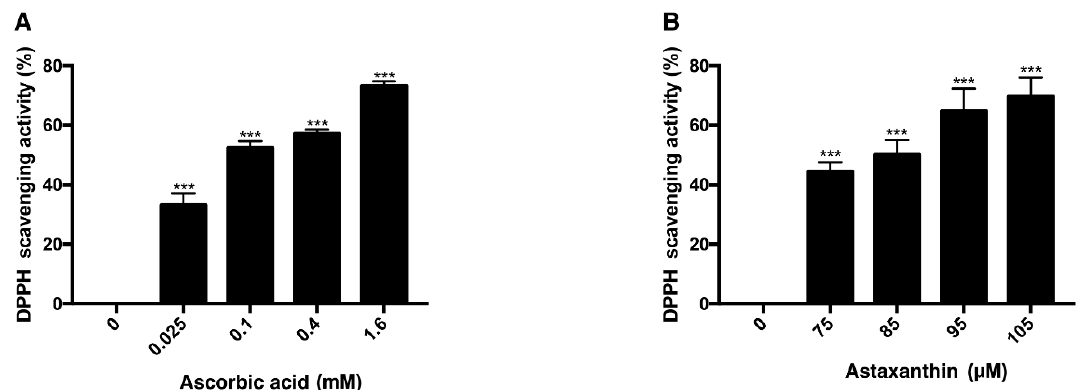
Figure 3. DPPH scavenging activity of ascorbic acid and astaxanthin. The antioxidative capacities of ascorbic acid and astaxanthin were determined by their capabilities to scavenge DPPH. Ascorbic acid (0.025–1.6 mM) was reacted with DPPH ( A ), and astaxanthin (75–105 µ M) was reacted with DPPH ( B ). The compounds were diluted in DMSO. Both compounds scavenged DPPH in dose-dependent way in 30 min of reaction time. Asterisks indicate a significant increment in DPPH scavenging activity compared with controls (*** p < 0.001). DPPH, 2,2-diphenyl-1-picrylhydrazyl; DMSO, dimethyl